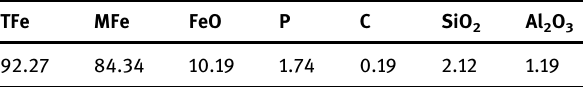
Table 1: Chemical compositions of the reduced iron ( mass %